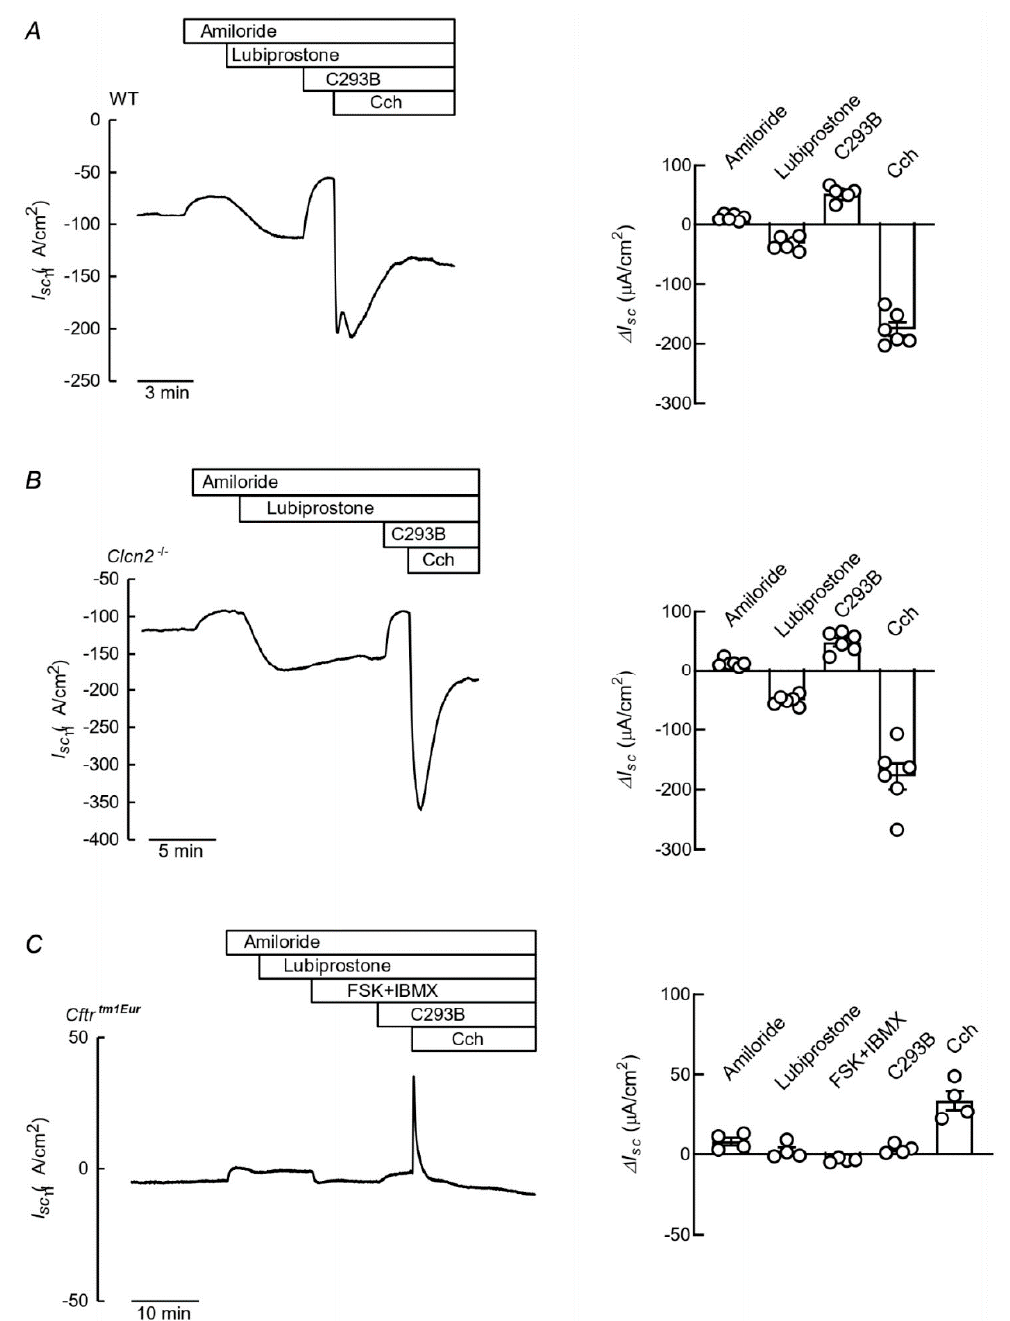
Figure 3. Effect of inactivation of Cl- channel ClC-2 on the effect of lubiprostone on anion secretion in the mouse colon. Traces showing recordings of short circuit currents (I SC ) as function of time obtained using distal colon from WT ( A ) or Clcn2 − / − ( B ) mice mounted in Ussing chambers. Additions as shown in the upper bars, were 0.1 μ M lubiprostone, 10 μ M chromanol 293B (C293B) and 100 μ M carbachol (Cch). All additions were made to the serosal side of the epithelium save for amiloride and lubiprostone, which was added apically. To the right of each trace corresponding bar graphs summarise the mean change in short circuit-current ( Δ I SC ) after the different additions as means ± SEM of the six animals for each genotype. The only statistically significant difference was between the lubiprostone responses that were larger in tissues from Clcn2 − / − mice (P = 0.00355 by one-tailed t -test). ( C ): Effect of the same additions as in A and B tested using colon tissue isolated from Cftr tm1Eur mice that express the CFTR Δ F08 mutant. Results summary on the right based on tissues from four animals.